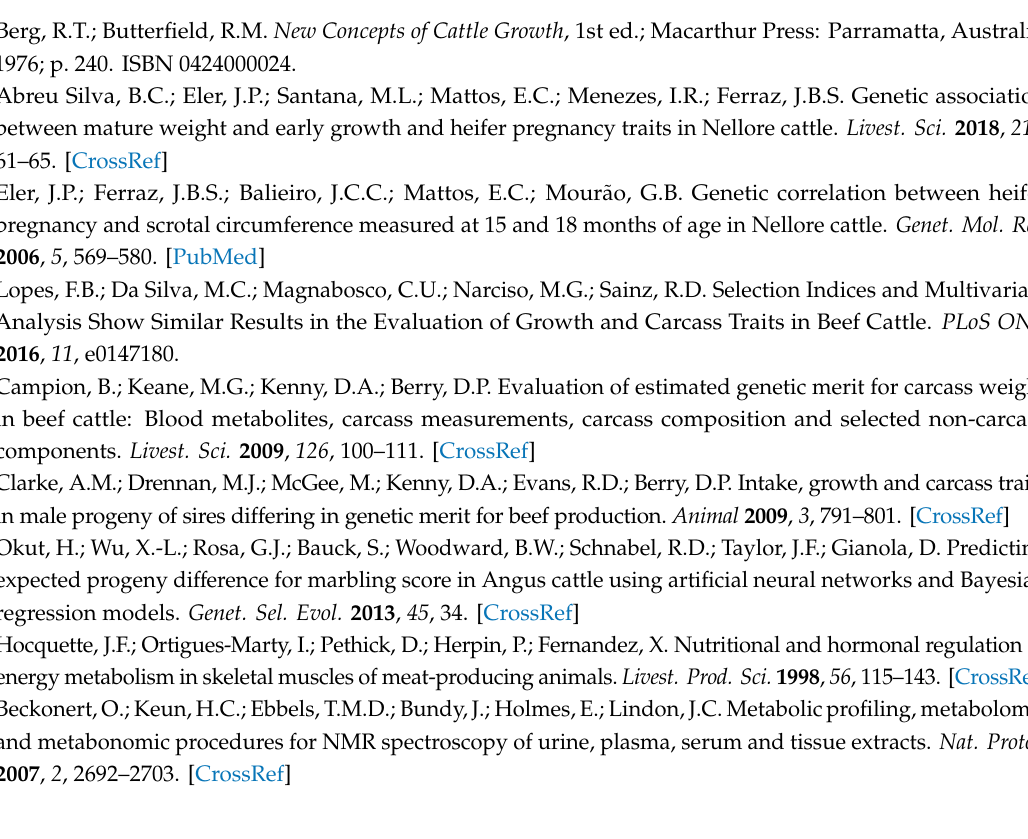
Table S1: Descriptive analysis of metabolites concentrations (mg / g of fresh meat). Figure S1: Validation statistics for PLS-DA on animals selected for growth. Figure S2: Validation statistics for PLS-DA on animals selected for